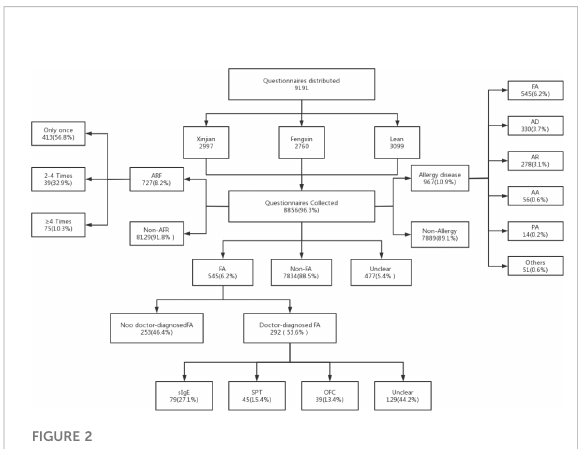
FIGURE 2 Overview of participation, distribution of ARF, and allergic